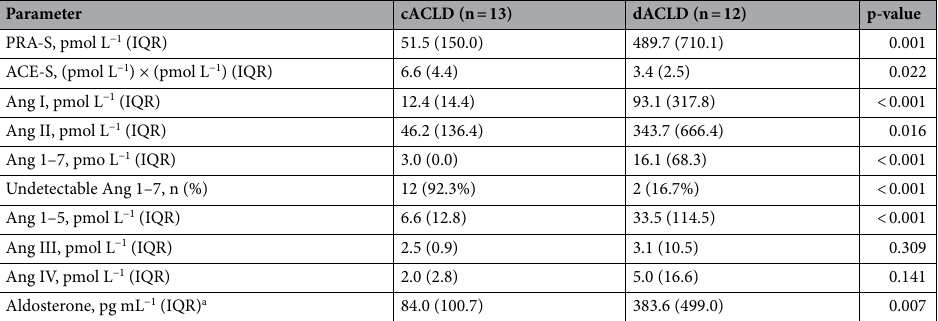
Table 2. Plasma levels of classical and alternative renin-angiotensin system (RAS) components in patients with compensated (cACLD) and decompensated cirrhosis (dACLD). ACE-S angiotensin converting enzyme surrogate, Ang angiotensin, cACLD compensated advanced chronic liver disease, dACLD decompensated advanced chronic liver disease, IQR interquartile range, PRA-S plasma renin activity surrogate, RAS renin– angiotensin system. a Available in n = 14 patients (cACLD: n = 7; dACLD: n =